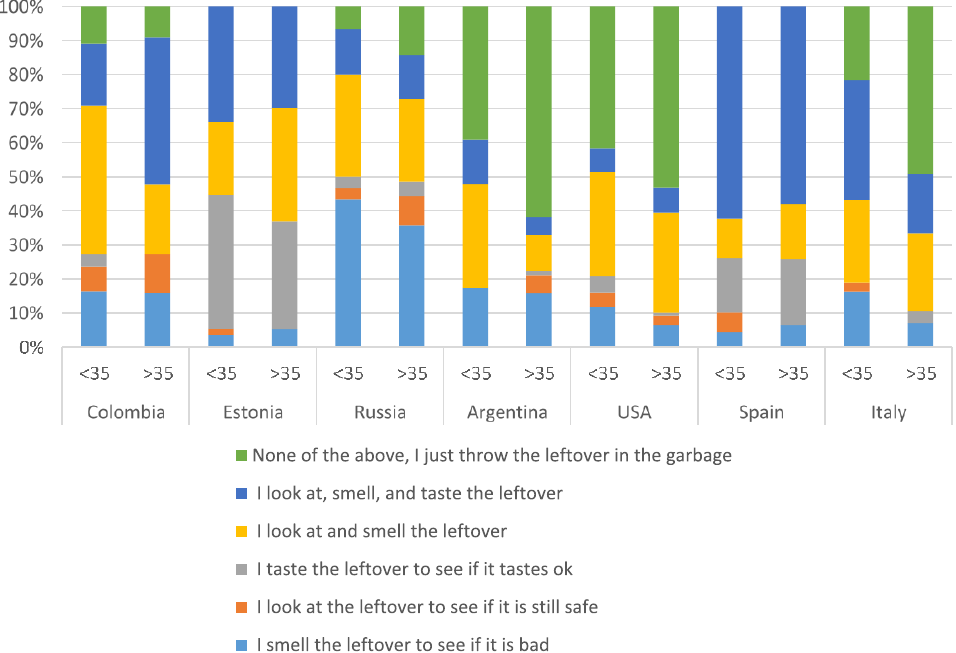
Figure 5. If you find a leftover in the refrigerator and do not know how long it has been in there, how do you determine if it is still safe to eat? (Select one). Results presented for respondents aged <35 and ≥35 in each country, by percentage. Table 7. If you find a leftover in the refrigerator and do not know how long it has been in there, how do you determine if it is still safe to eat? Results given in % of respondents.